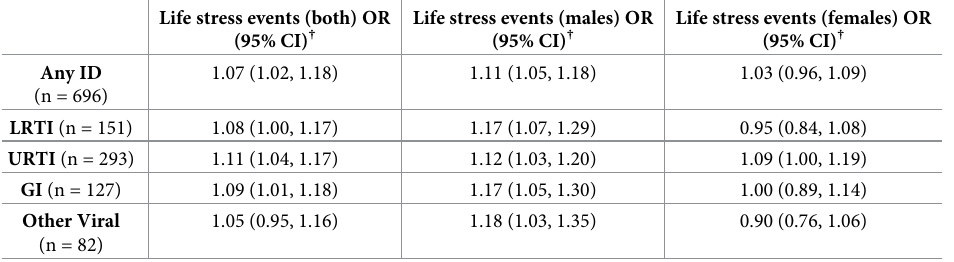
Table 4. Binary logistic regression analyses showing the relationship between increasing life stress events and infection-related hospitalisation before the age of 5 years (N = 2,141).